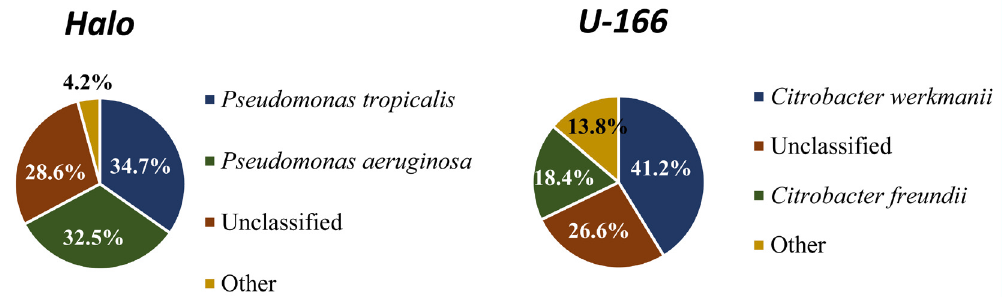
Figure 3. 16S amplicon sequencing on the Halo and U-166 DN consortium after 24 h culturing in Indole Nitrite medium. Genomic DNA was isolated from the Halo and the U-166 DN consortium and the V4 region of the 16S was analyzed.